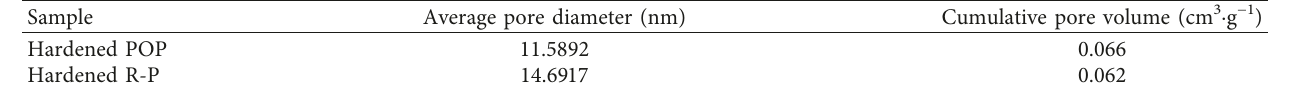
Figure 7: The morphology and pore size distribution of hardened POP and hardened R-P. Table 4: Pore characteristics of hardened POP and hardened